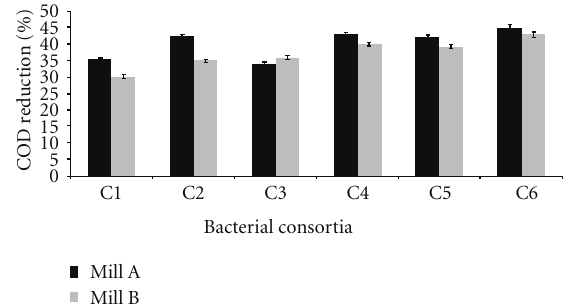
Figure 2: COD reduction of sample back water :black liquor (60:40) using di ff erent consortia after 45 hrs as per control— 5800 mg/L (mill A) and 7850mg/L (mill